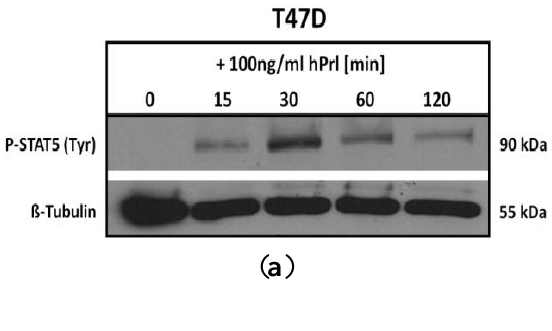
5. S5-DBD-PA interferes with the nuclear translocation of Stat5 upon prolactin induction. ( a ) Stat5-activation in T-47D breast cancer cells stimulated with Prl. ( b ) Immunofluorescent images of lentiviral transduced T-47D cells either expressing S5-DBD-PA or hTRX were taken 7 days after infection by confocal laser scanning microscopy in the absence or presence of Prl. Cells were stained with a Flag-tag antibody, marked with a Alexa 546 conjugated secondary antibody, and a Alexa 647 conjugated antibody recognizing tyrosine phosphorylated Stat5a and Stat5b. Nuclear staining was performed with DAPI and fluorescence marker (eGFP) expression of the SiEW-lentiviral transfer vector was